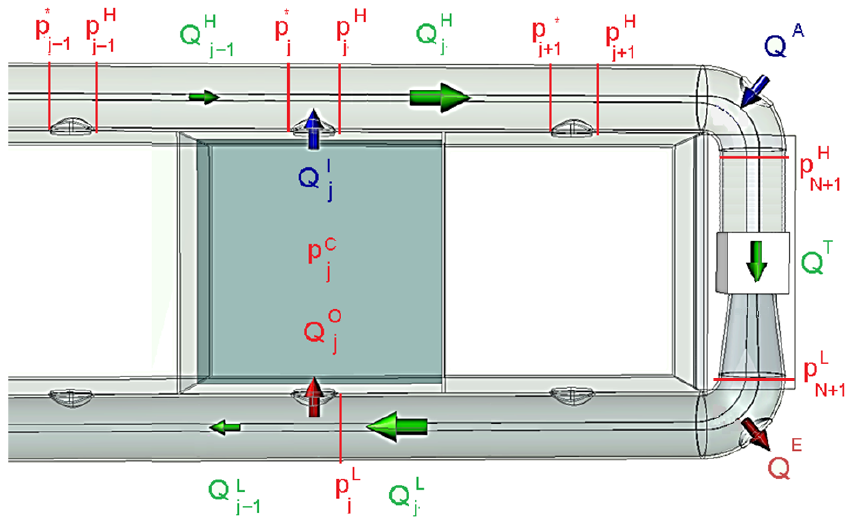
Figure 18. Reference sketch for Seabreath air circulation